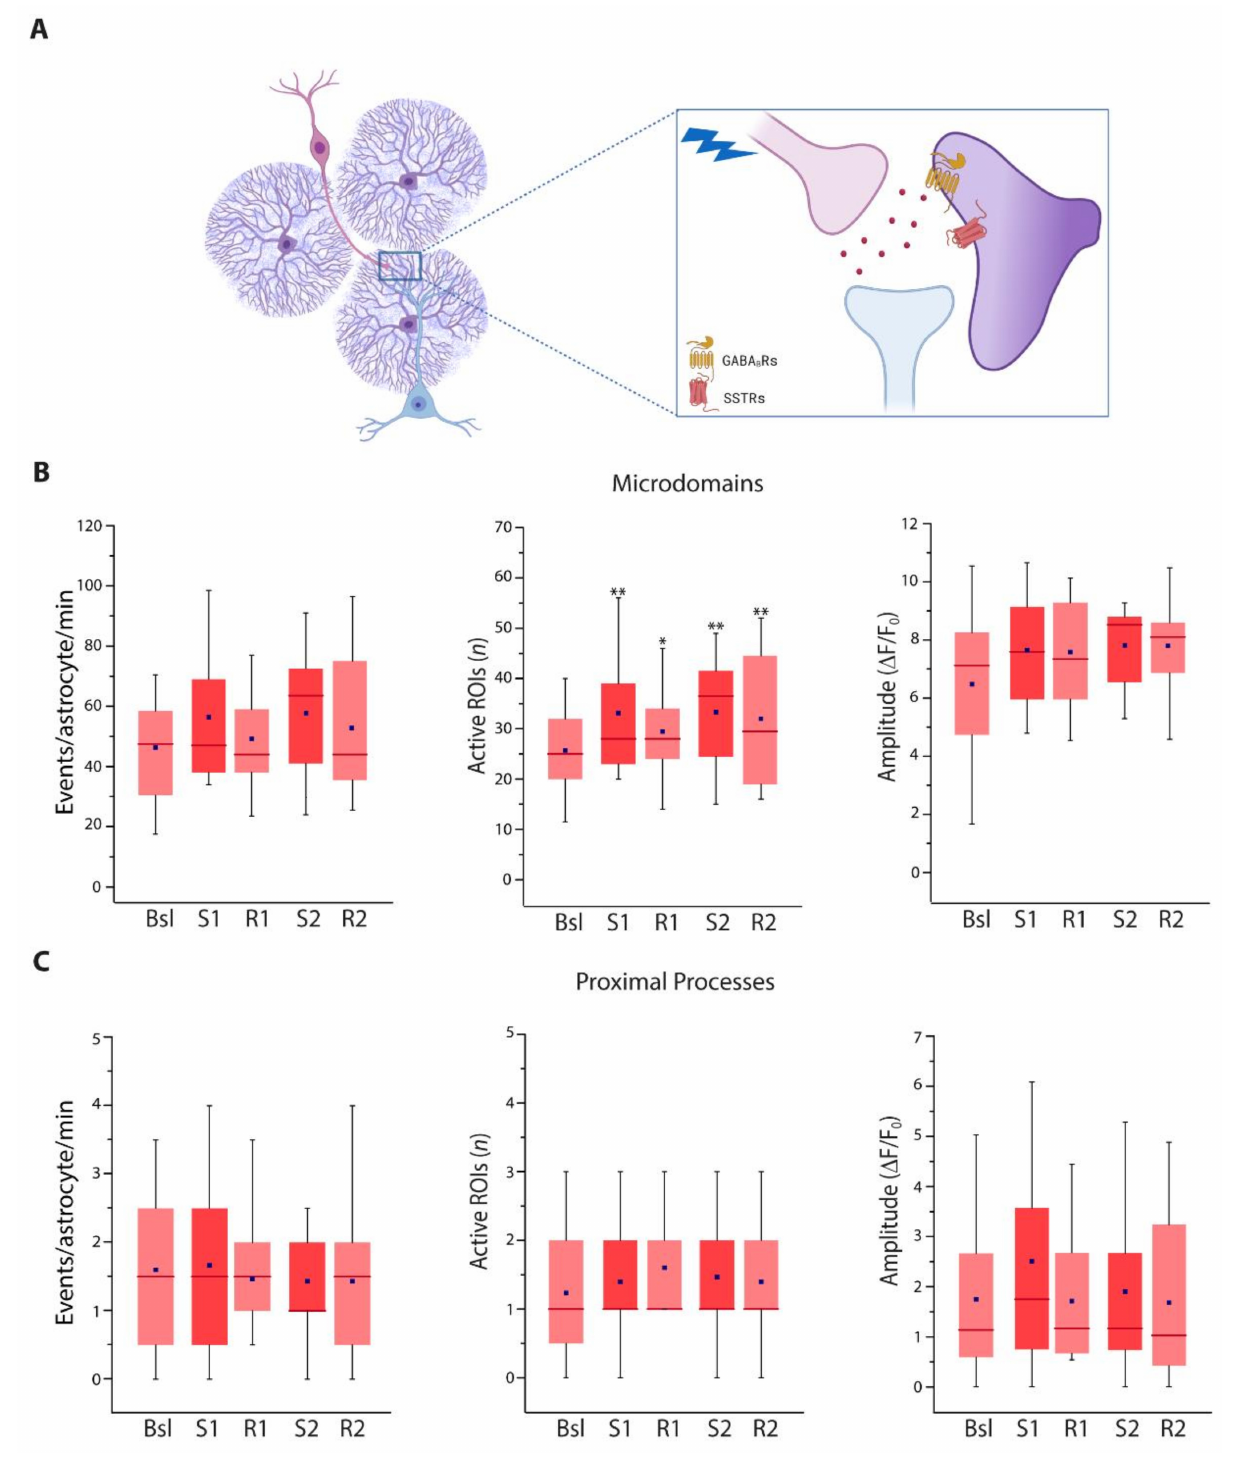
Figure 6. The neuropeptide somatostatin modulates the astrocyte Ca 2+ response to SST interneuron stimulation. ( A ) Schematic showing the possible involvement of astrocyte SSTRs in the Ca 2+ responses to SST interneuron stimulation. ( B , C ) Ca 2+ signal dynamics at microdomains (7532 total events) ( B ) and proximal processes (228 total events) ( C ) in the presence of the SSTR antagonist CYN 15406 (15 astrocytes, 8 slices, 4 mice). * p < 0.05, ** p < 0.01, One-way repeated measures ANOVA on ranks with Dunnett’s test was used to compare all other conditions to Bsl condition.